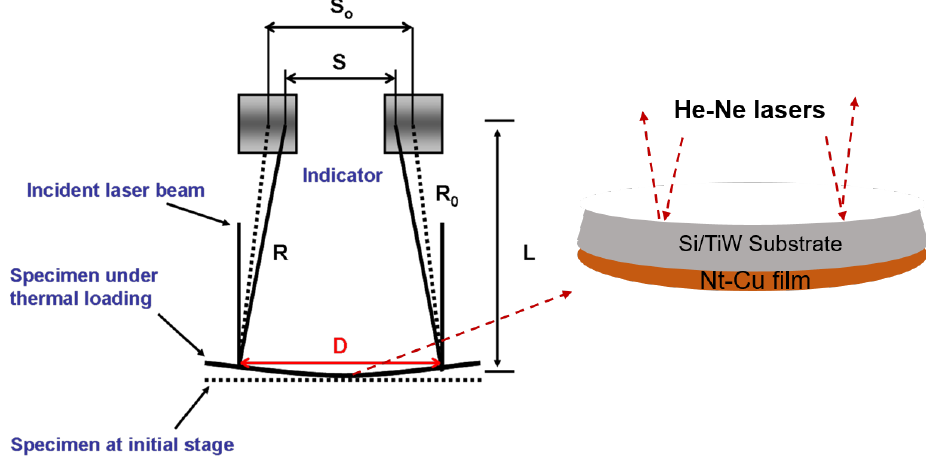
Figure 1. Schematic of the thermal-stress measurement. The dotted and solid lines represent the films before and during heating, respectively.